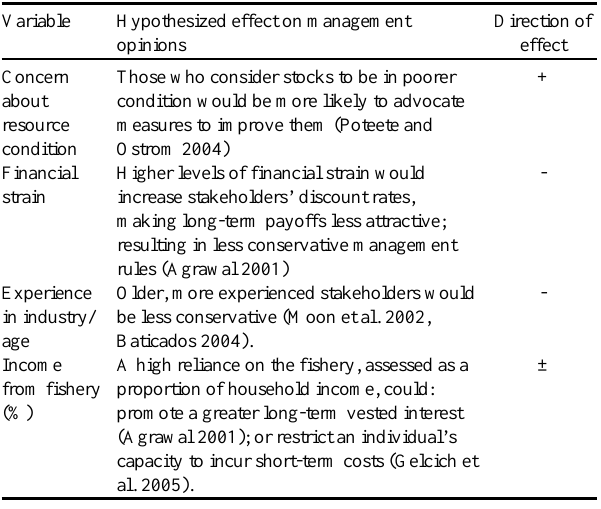
Table 1 . Predictor variables and hypothesized effects on the conservativeness of management